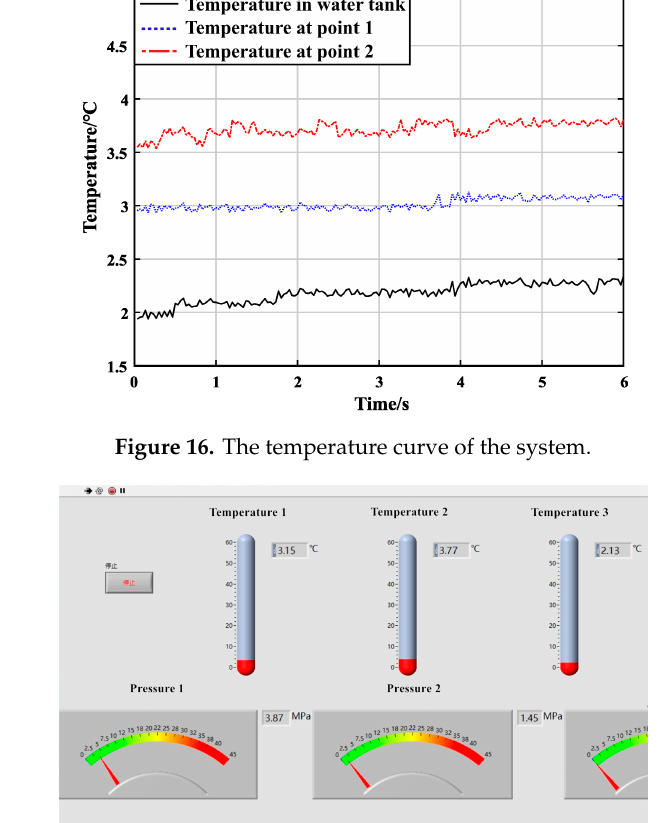
Figure 19. Temperature change of opening thermoelectrical refrigeration units. Based on the test, the following results can be drawn: (1) In the case of an ambient temperature of about 28 °C, the chiller can refrigerate 500 L of water from 25 °C to 2 °C in about 2 h; (2) the hydraulic system including the plunger pump causes a temperature increase of 1.5 °C for seawater, and if the operating environment is 10 °C, the temperature increase of the hydraulic system will be decreased; (3) four sets of semiconductor refrigerating plates can compensate a temperature rise of 0.6 °C in total, and the length of device is only 24 cm. If the number of refrigerating plates is increased, the temperature increase compensation capability can be enhanced.